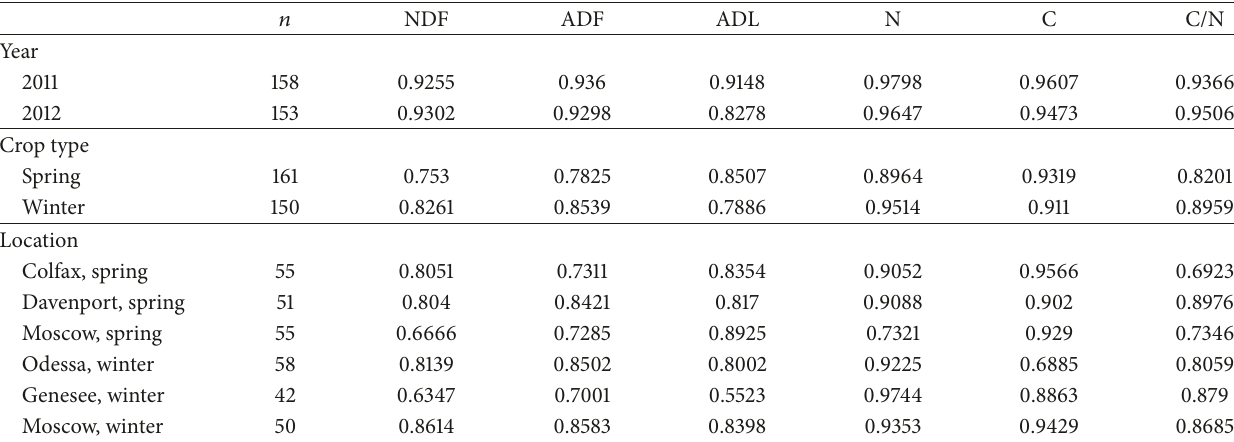
Table 6: Pearson correlation coefficients for spring and winter canola residue traits measured using laboratory reference methods and compared to NIRS predicted values over two years and three locations for each crop type. For each pair, the level of significance was < 0.0001 at 𝑃 < 0.05 . 𝑛 NDF ADF